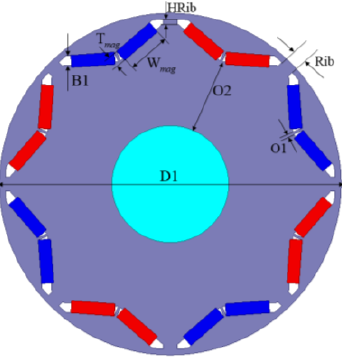
Figure 2. PMSM optimization parameters .